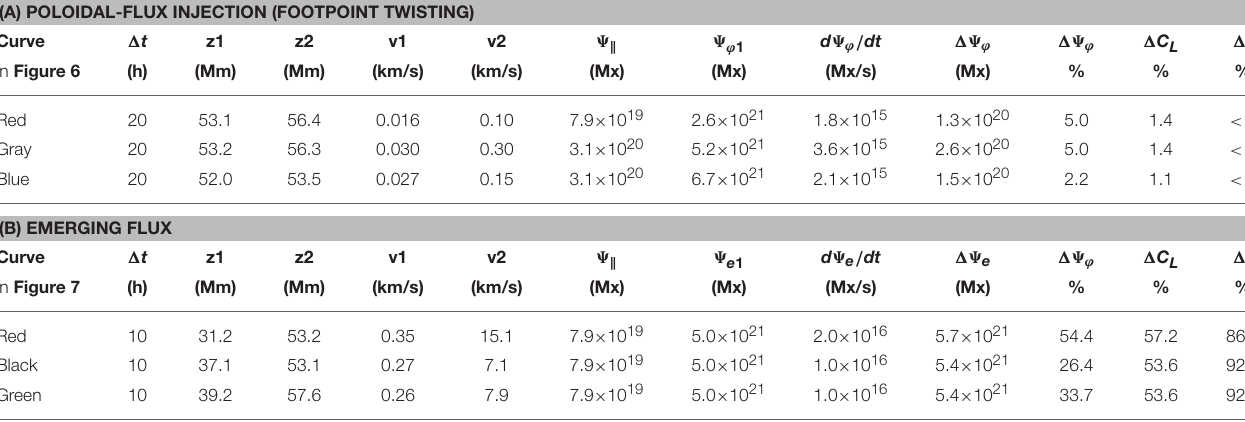
In the first column the identification of the curves displayed in Figures 6 , 7 is defined. 1 t represents the time interval prior to the eruption over which the changes of the parameters presented in the rest of the table are followed. Subscript “1” denotes the values at the beginning of the interval, whereas the subscript “2” represents the values at the onset of the eruption. For details see the main